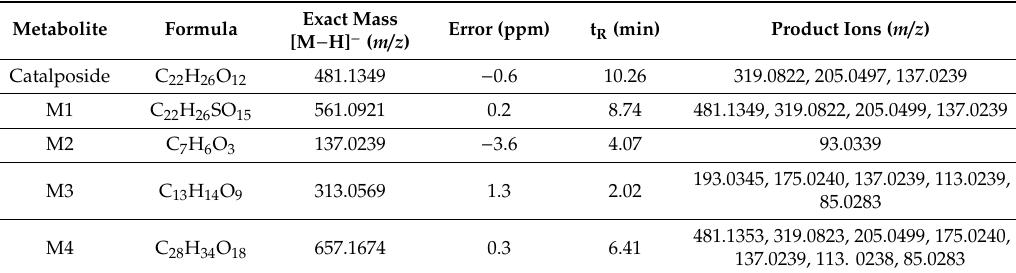
Table 1. Molecular formulae, deprotonated molecular ions ([M − H] − ), mass errors, retention times (t R ), and product ions of catalposide and its metabolites were identified after incubation of catalposide with human hepatocytes and intestinal microsomes.